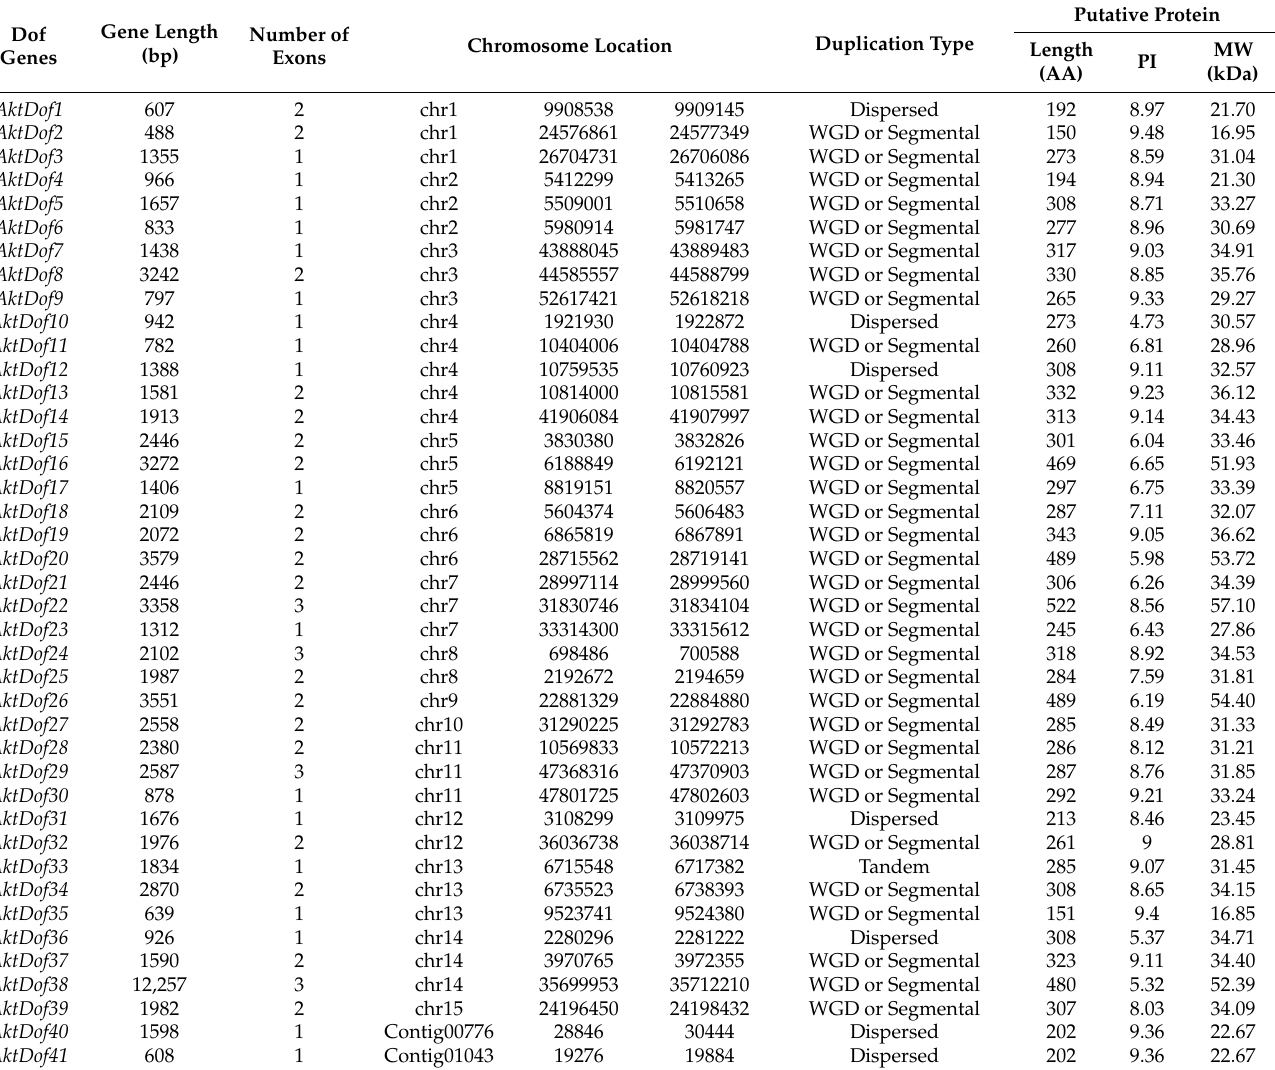
Table 1. Characteristics of the identified Dof gene family members from the A. trifoliata